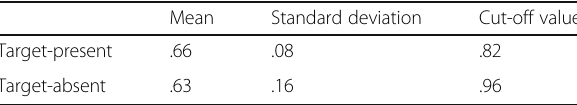
Table 8 Norming data from control sample for